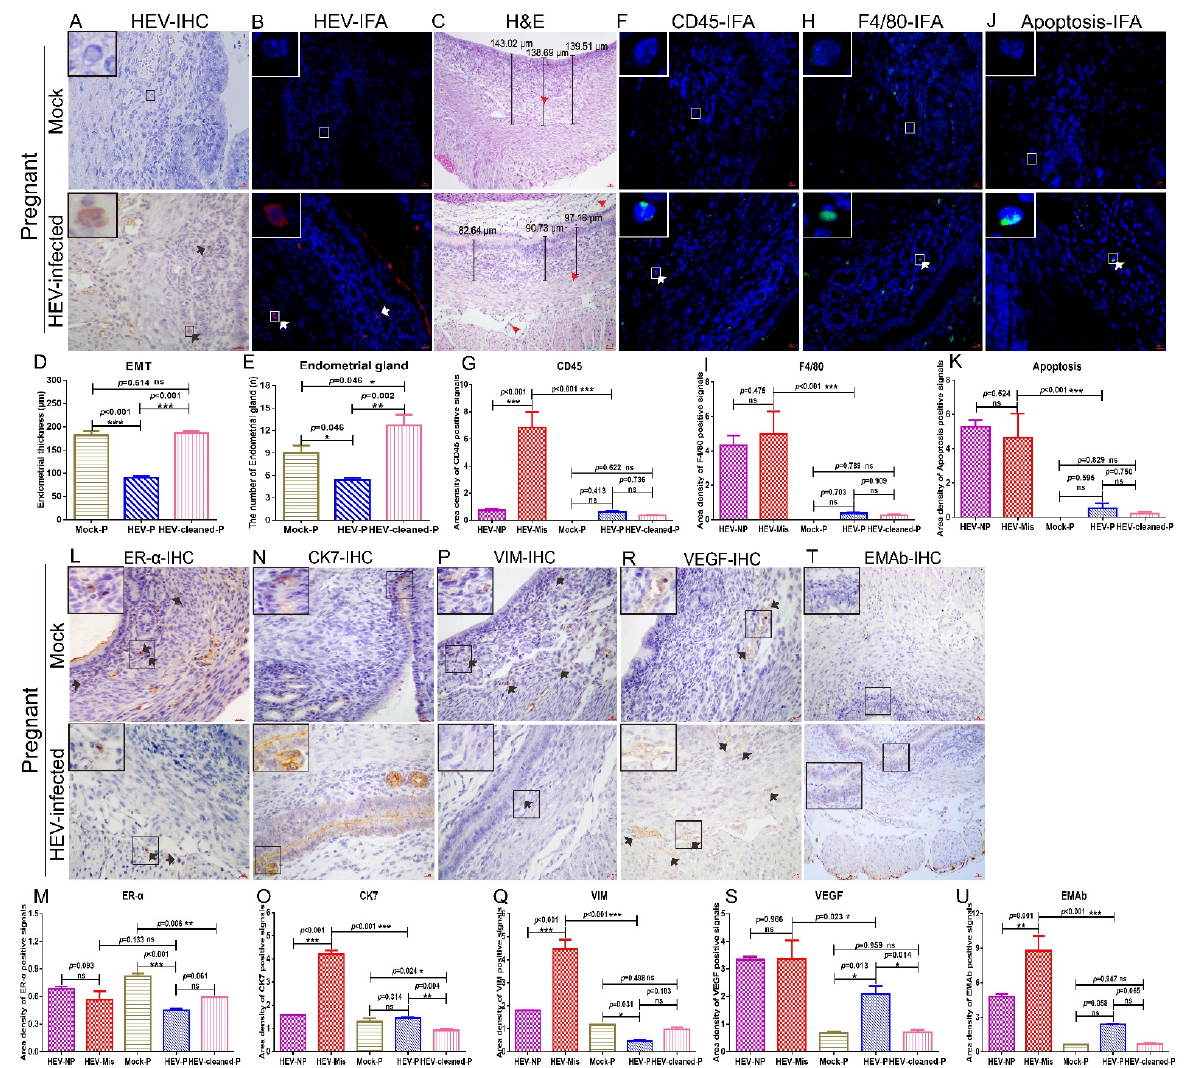
Figure 6. Uterine damages in HEV ‐ infected pregnant mice are mild. HEV antigens were detected in the uteruses of mock or HEV ‐ infected pregnant mice by IHC ( A ) and IFA ( B ). ( C ) H & E analysis of uteruses from mock pregnant mice or HEV ‐ infected pregnant mice. The presence of CD45 ( F ), F4/80 ( H ), and apoptotic cells ( J ) in the uteruses of mock pregnant mice or HEV ‐ infected pregnant mice were identified by IFA. Nuclei were stained with DAPI. ( D ) The EMT of HEV ‐ infected mice was measured and compared with that of mock pregnant, HEV ‐ infected pregnant mice, or mice that became preg ‐ nant after HEV clearance. ( E ) The number of endometrial glands was calculated and compared with that of mock pregnant mice, HEV ‐ infected pregnant mice, or mice that became pregnant after HEV clearance ( E ). Positive signals of CD45 ( G ), F4/80 ( I ), and apoptotic cells ( K ) in the uteruses of mock pregnant mice, HEV ‐ infected pregnant mice, and mice that be ‐ came pregnant after HEV clearance were separately calculated by Image ‐ Pro Plus 6.0 software and compared by IBM SPSS Statistics 21 software. * p < 0.05; ** p < 0.01; *** p < 0.001. The expressions of ER α ( L ), CK7 ( N ), VIM ( P ), VEGF ( R ), and EMAb ( T ) in the uteruses of mock pregnant mice or HEV ‐ infected pregnant mice were determined by IHC. Positive signals of ER α ( M ), CK7 ( O ), VIM ( Q ), VEGF ( S ), and EMAb ( U ) in the uteruses of mock pregnant mice, HEV ‐ infected pregnant or nonpregnant mice, and mice that became pregnant after HEV clearance were separately calculated by Image ‐ Pro Plus 6.0 software and compared by IBM SPSS Statistics 21 software. * p < 0.05; ** p < 0.01; *** p < 0.001.